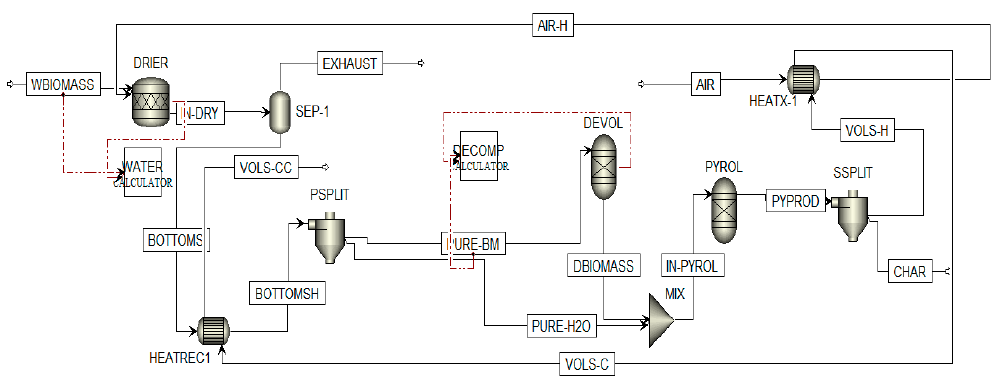
Figure 5. Heat recovery for pyrolysis (first attempt).